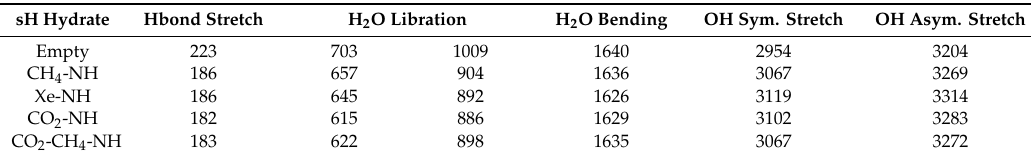
Table 2. Convoluted IR spectra peak frequencies (cm − 1 ) of host (H 2 O) vibrations in sH gas hydrates at equilibrium (0 K, 0 GPa). sH Hydrate Hbond Stretch H 2 O Libration H 2 O